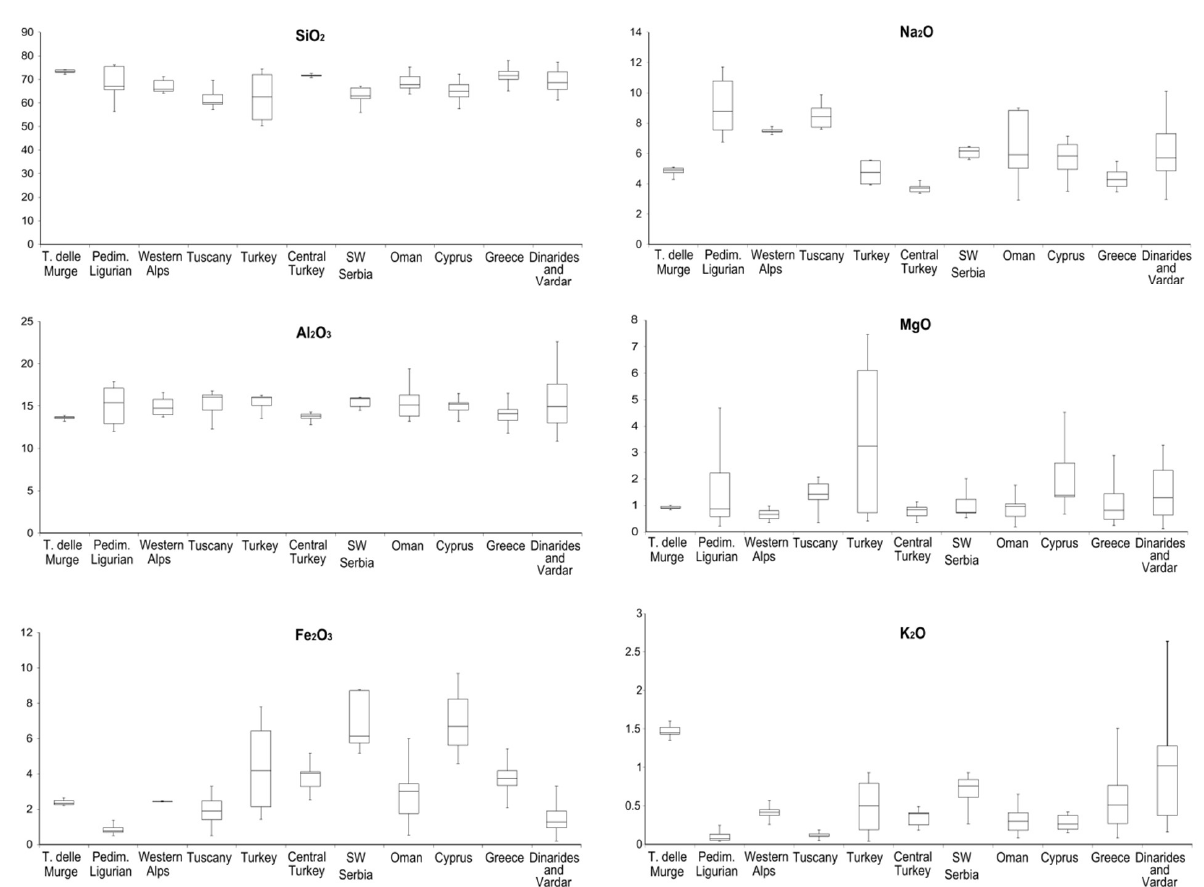
Figure 10. Box and whiskers plot for major oxides (SiO 2 , Al 2 O 3 , Fe 2 O 3 , Na 2 O, MgO, K 2 O) in considered samples and further Tethyan plagiogranites rocks. The values are expressed in %.